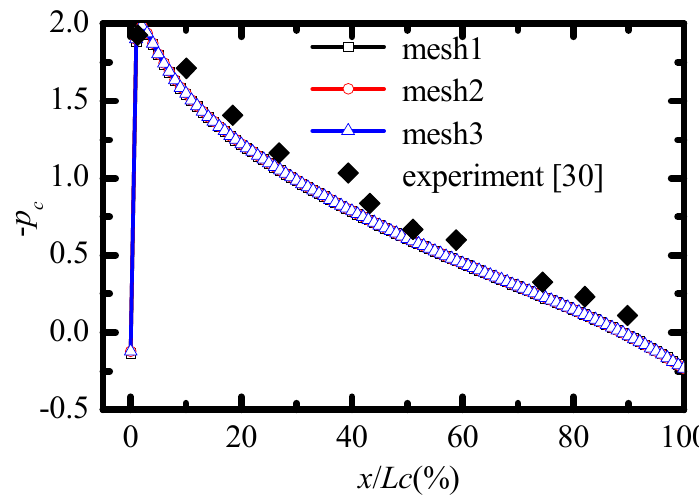
Figure 5. Mesh independence study.